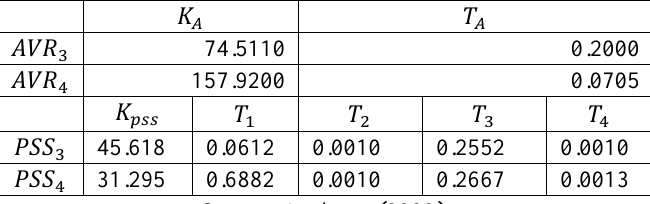
Figure 4: Closed-loop pole map. Table 2: Optimal control parameters.